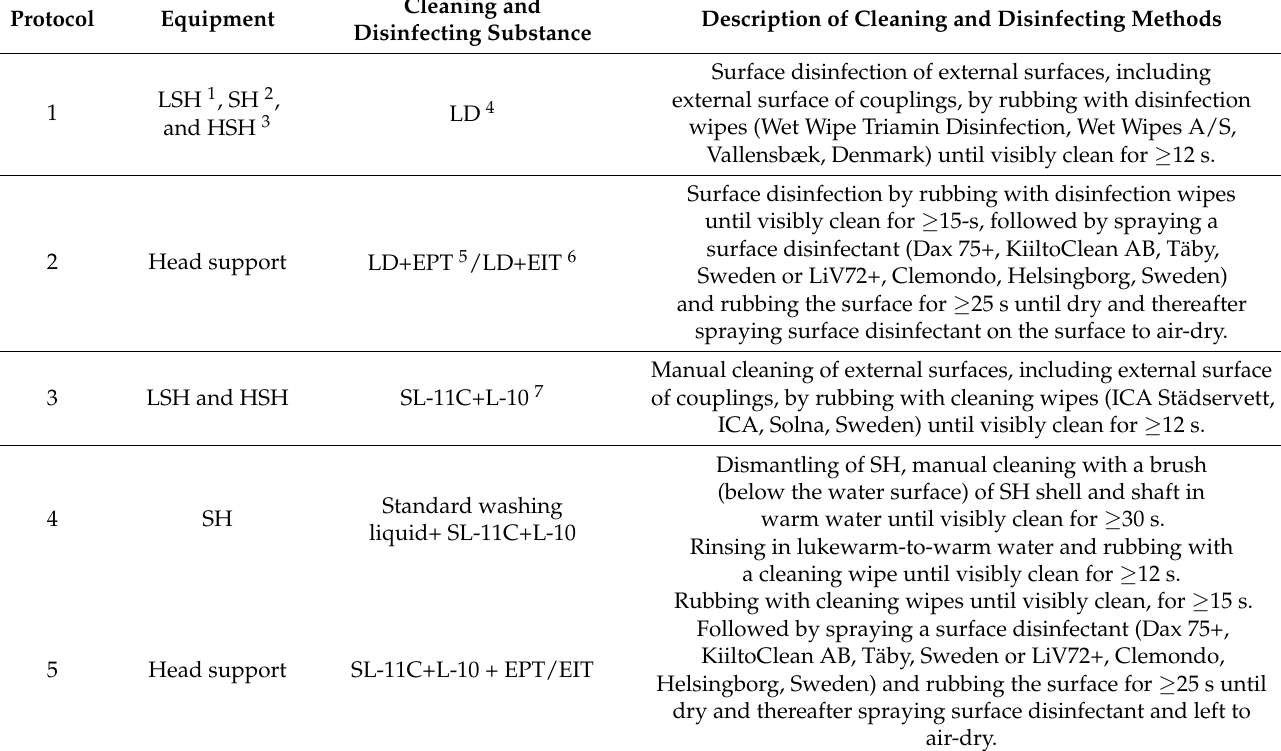
Table 3. Protocols used for cleaning and disinfection of handpieces and the head